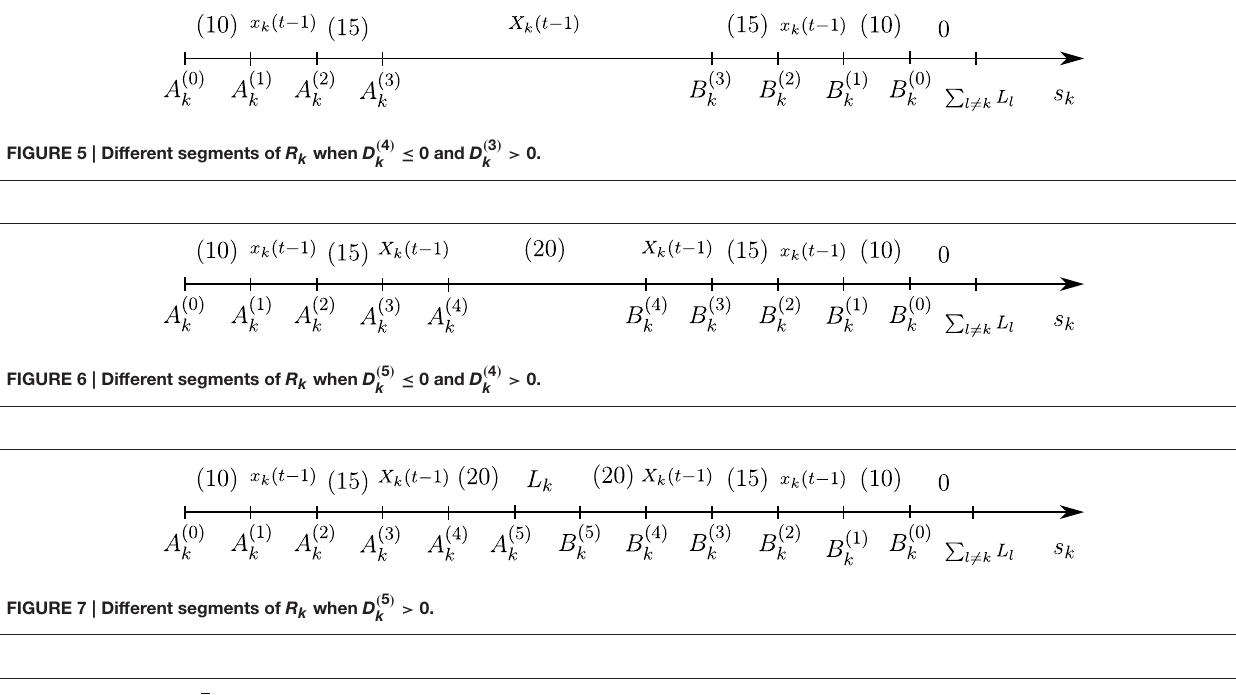
FIGURE 7 | Different segments of R k when D ( 5 ) k > 0.